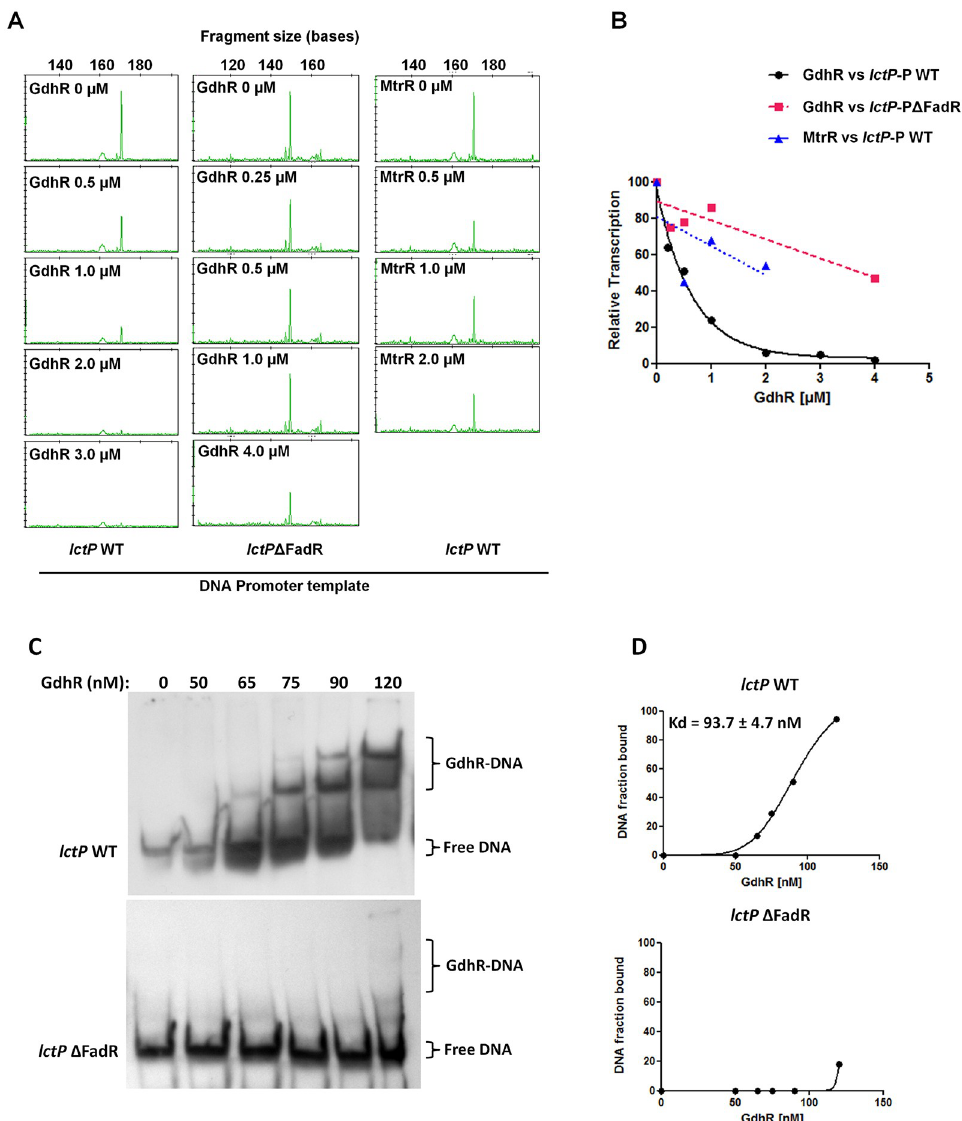
Fig 6. GdhR directly represses lctP transcription. A. In vitro transcription was conducted in the presence of increasing concentrations of purified GdhR and 50 nM RNAP σ 70 using as template a DNA fragment encoding lctP promoter from -192 to +381 relative to TSS ( lctP WT) and the same fragment harboring a 21 bp deletion in the FadR consensus DNA- binding motif ( lctP Δ FadR). The size of the lctP transcript peaks is given at the top x axis. Purified MtrR protein was used as specificity control of the transcription inhibition reaction. B. Transcription inhibition curves were generated by plotting the height of the peaks (considering the 0 μ M protein reaction as the 100% transcription point) vs. transcription factor molar concentration. (C) Binding of GdhR to WT lctP promoter from -192 to +99 relative to the TSS ( lctP WT) and to the same promoter fragment harboring the 21 bp deletion in the FadR DNA-binding motif ( lctP Δ FadR) was compared by EMSA. (D) GdhR binding curves to the WT and mutant lctP probes and the dissociation constant (Kd) were determined by densitometry from the EMSA gels adjusting the data to a nonlinear regression analysis using the Hill equation